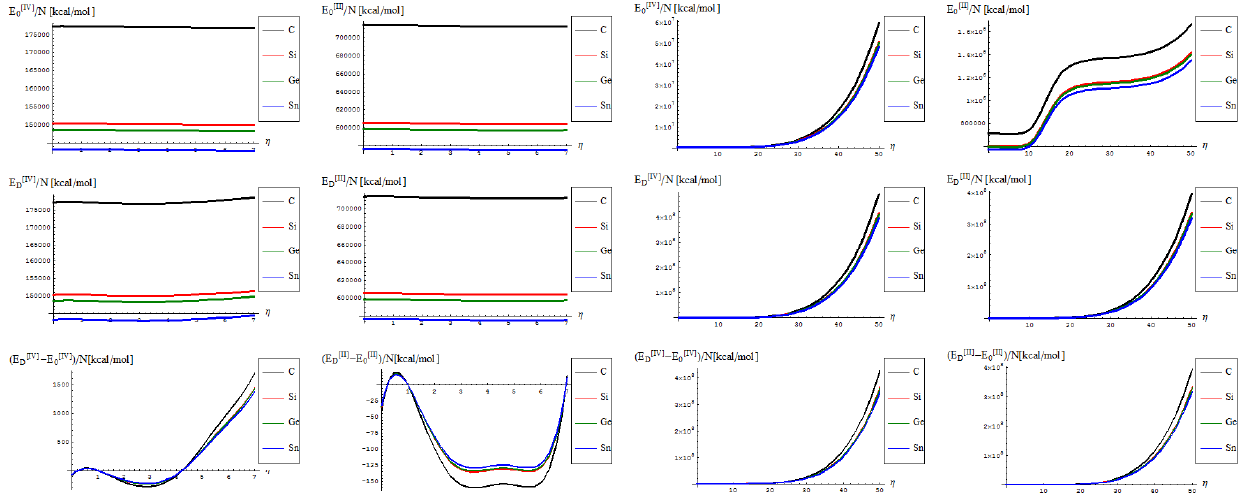
Figure 6. Side-by-side canonical internal energies of bondons in honey-comb supercells of Figure 2, as computed with the fourth order formulation of Equation (13) side by side with the former second order formulation of reference [16], for pristine “0” (upper row), defective “D” (middle row) and their differences (lower row),